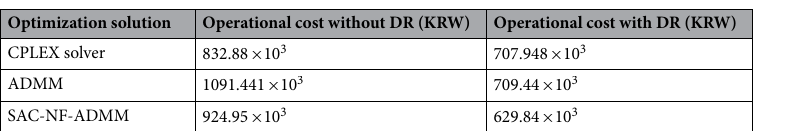
Table 3. Comparison of proposed optimization method cost performance (KRW) with centralized-ADMM and CPLEX solver.